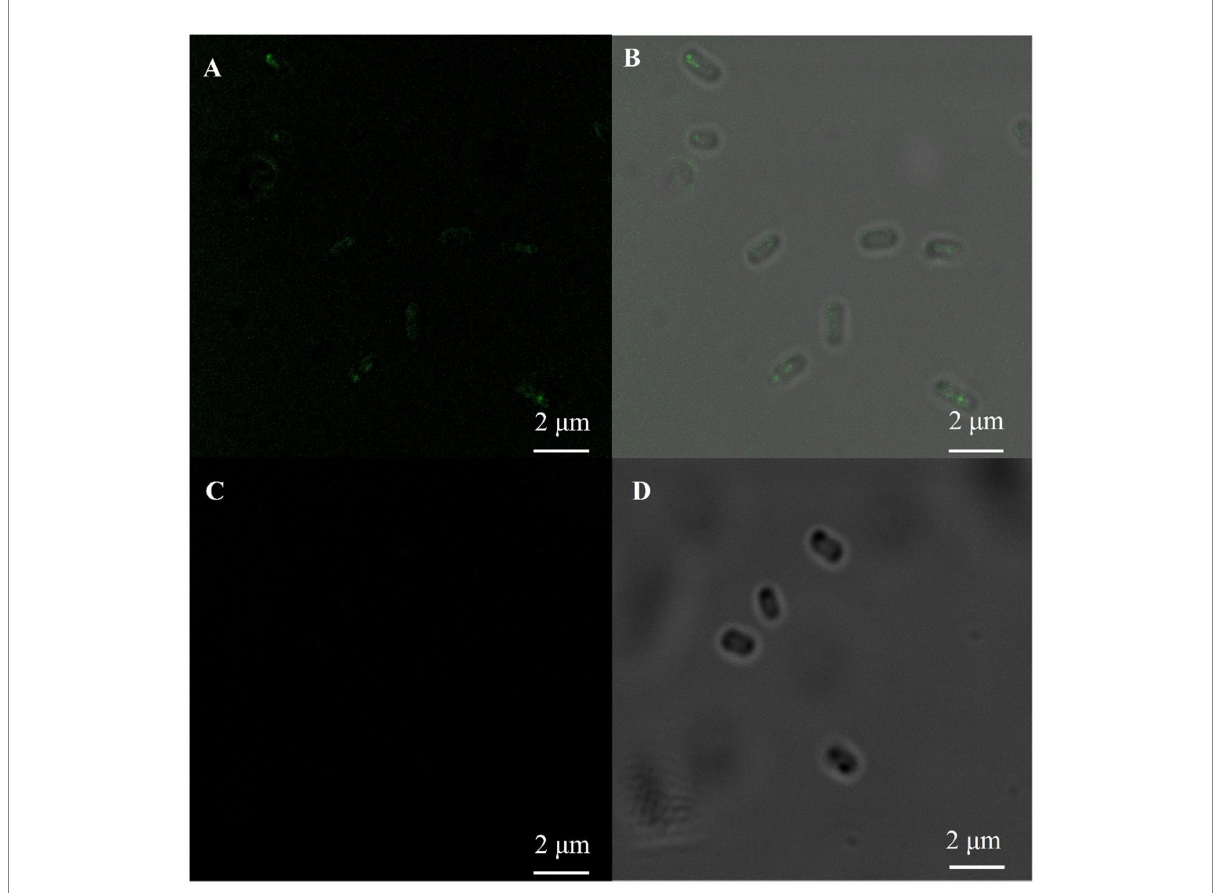
FIGURE 2 Immunofluorescent labeling of his-tag on the cell surface of E. coli . Fluorescence microscopy (A,C) and bright-field (B,D) images of PETase (C,D) and HCSD (A,B) displayed on E. coli cells. The E. coli cells were immunologically labeled with the anti-his mouse monoclonal antibody as the first antibody and rabbit IgG (H + L) HRP-conjugated anti-rat as the second anti-body.